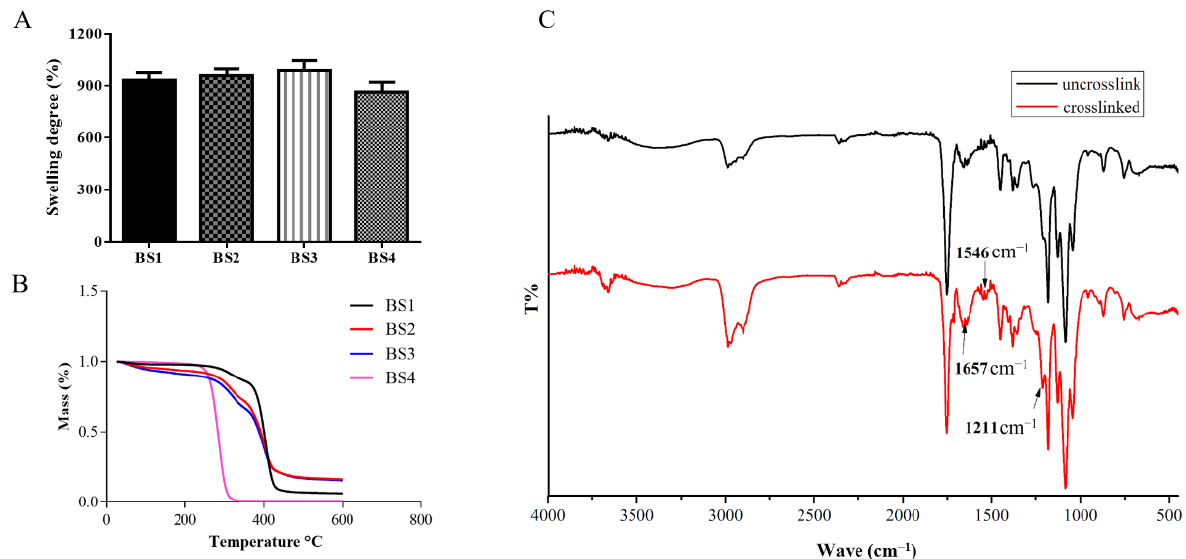
Figure 4. Swelling ability of bilayer scaffolds ( A ), TG analysis of bilayer scaffolds ( B ), FTIR spectra obtained for PCL/RHC inner layer samples that were uncrosslink and crosslinked ( C ).